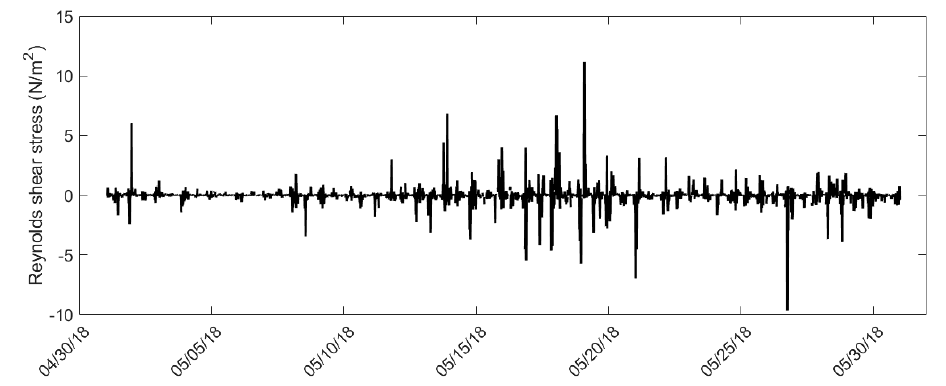
Figure 6. Time series of Reynold shear stress ( R S ) calculated from velocity measurements recorded by the ADV over the May deployment.